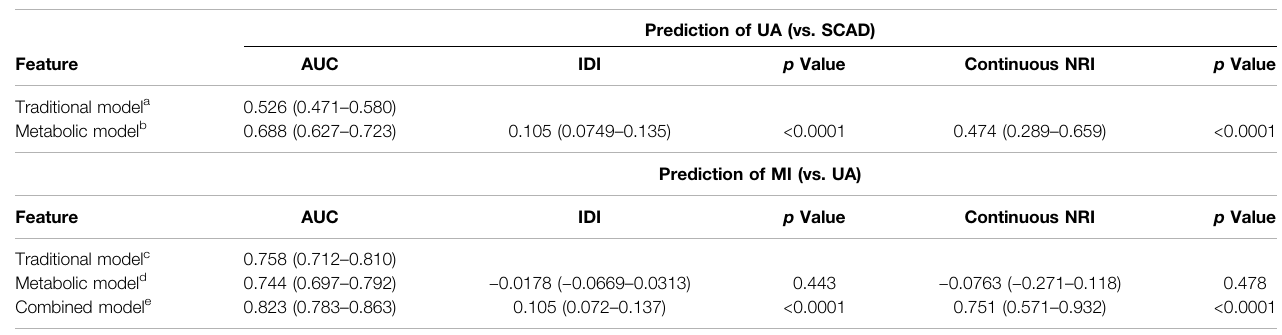
TABLE 2 | Model performance measures (95% CIs) for discrimination of CAD subtypes in the discovery cohort.